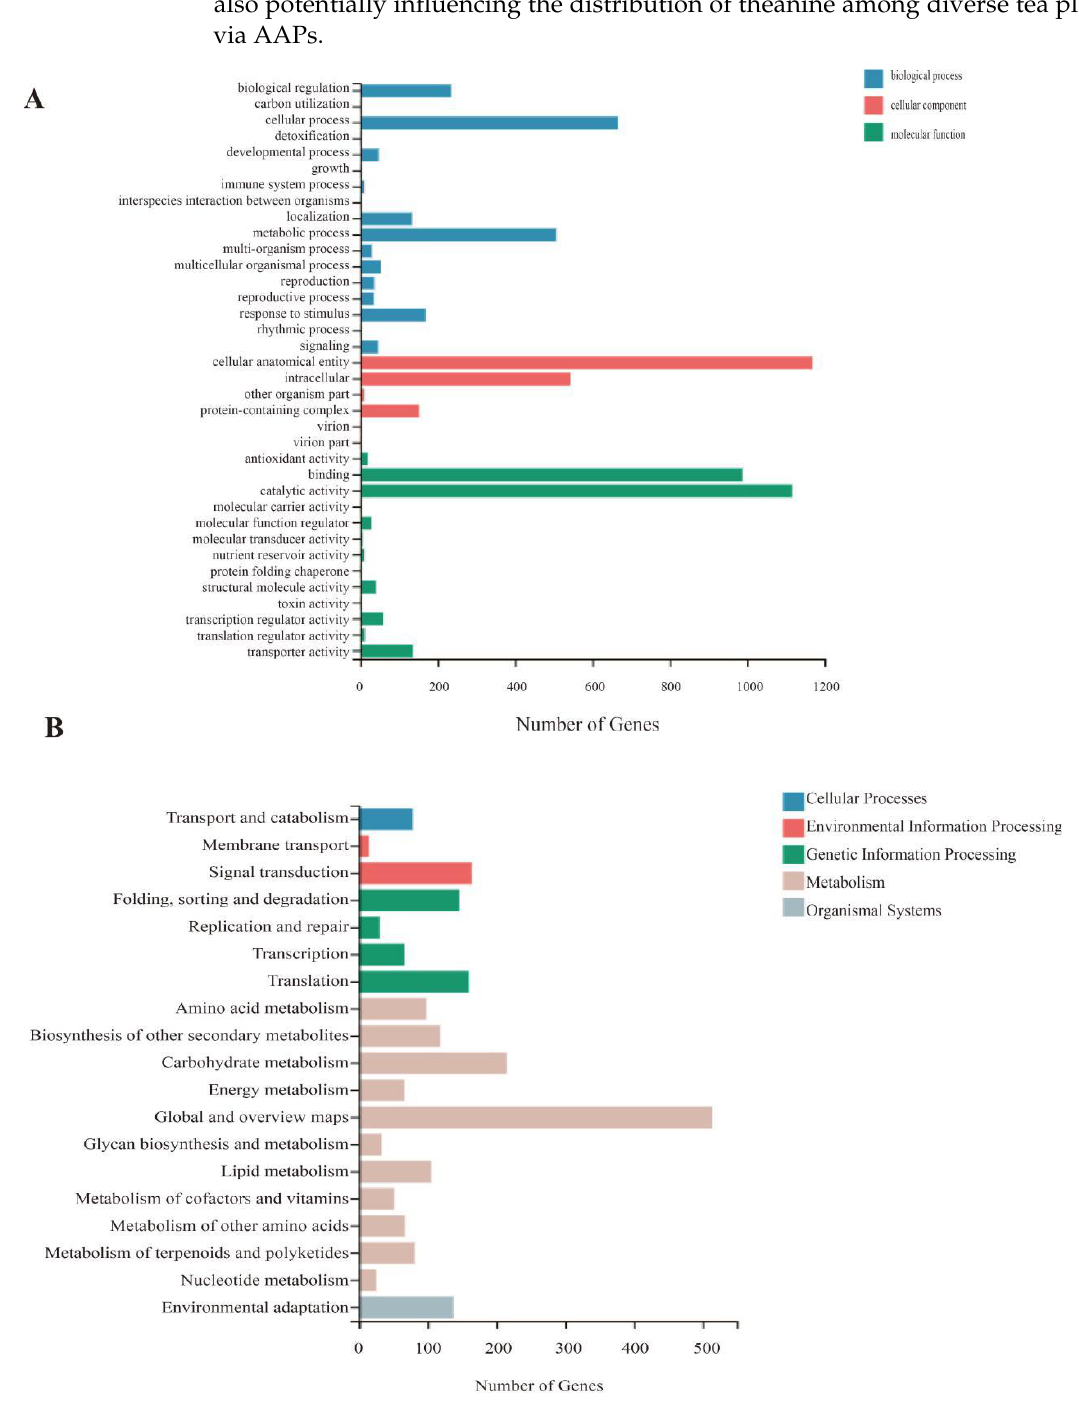
Figure 6. GO and KEGG classification of differentially expressed genes between the control and S85 treatment groups. ( A ) The x-axis presents the number of genes annotated with a particular GO term, whereas the y-axis presents the GO terms used for the functional classification ( B ) The x-axis presents the number of genes assigned to a particular KEGG pathway, whereas the y-axis presents the enriched KEGG pathways.